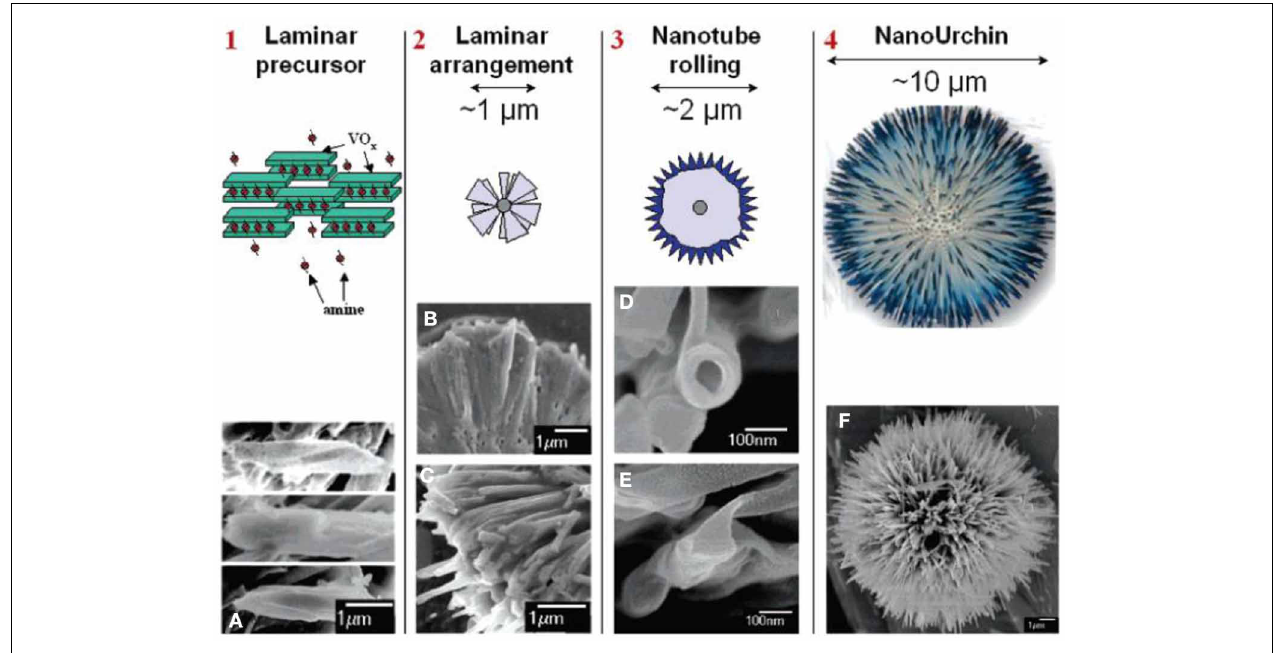
FIGURE 2 | Schematic illustration of the morphology evolution and the growth mechasnim of vanadium oxide nanourchin. (A–F) : SEM images of the as-synthesized nanostructures at